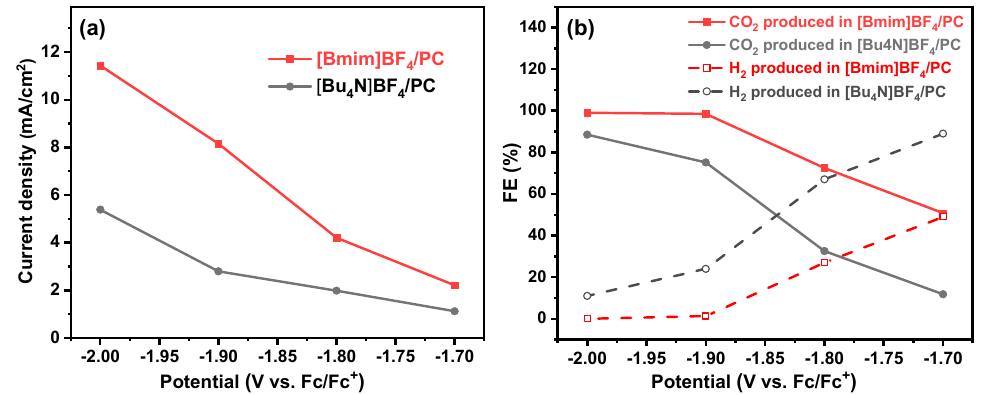
Figure 6. The current density ( a ) and Faradaic efficiency (FE) of CO and H 2 ( b ) for electrocatalytic CO 2 conversion in [Bu 4 N]BF 4 /PC and [Bmim]BF 4 /PC electrolyte solution.